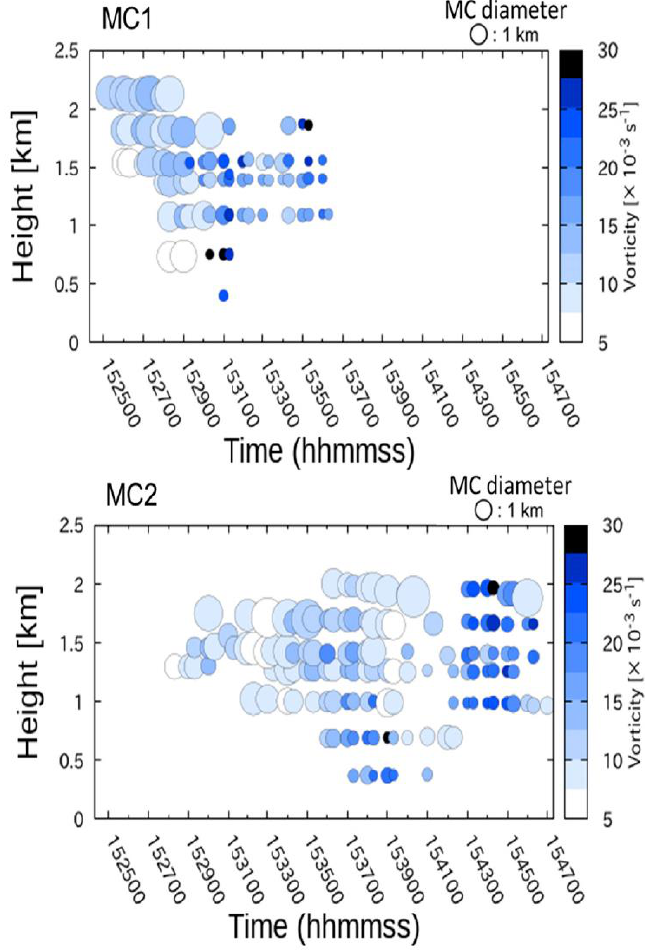
Figure 6. Time-height series of misocyclones: (( top ) MC1, ( bottom ) MC2). Size of the circles expresses the diameter of the misocyclones and the color of the circles expresses the vorticity.